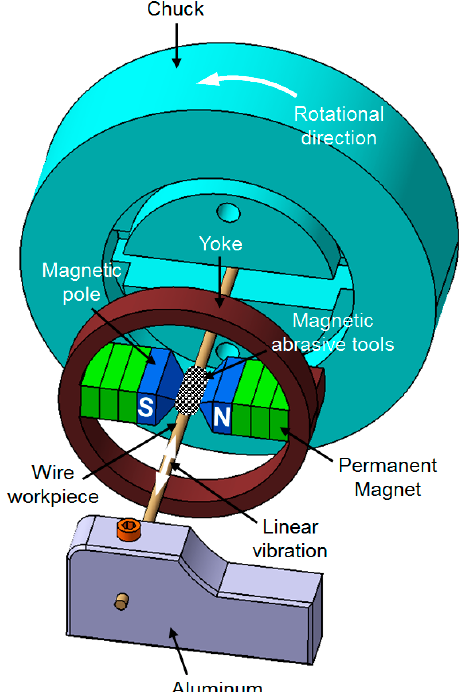
Figure 2. Schematic diagram of ultra-high-precision magnetic abrasive finishing for wire material using a rotating magnetic field.